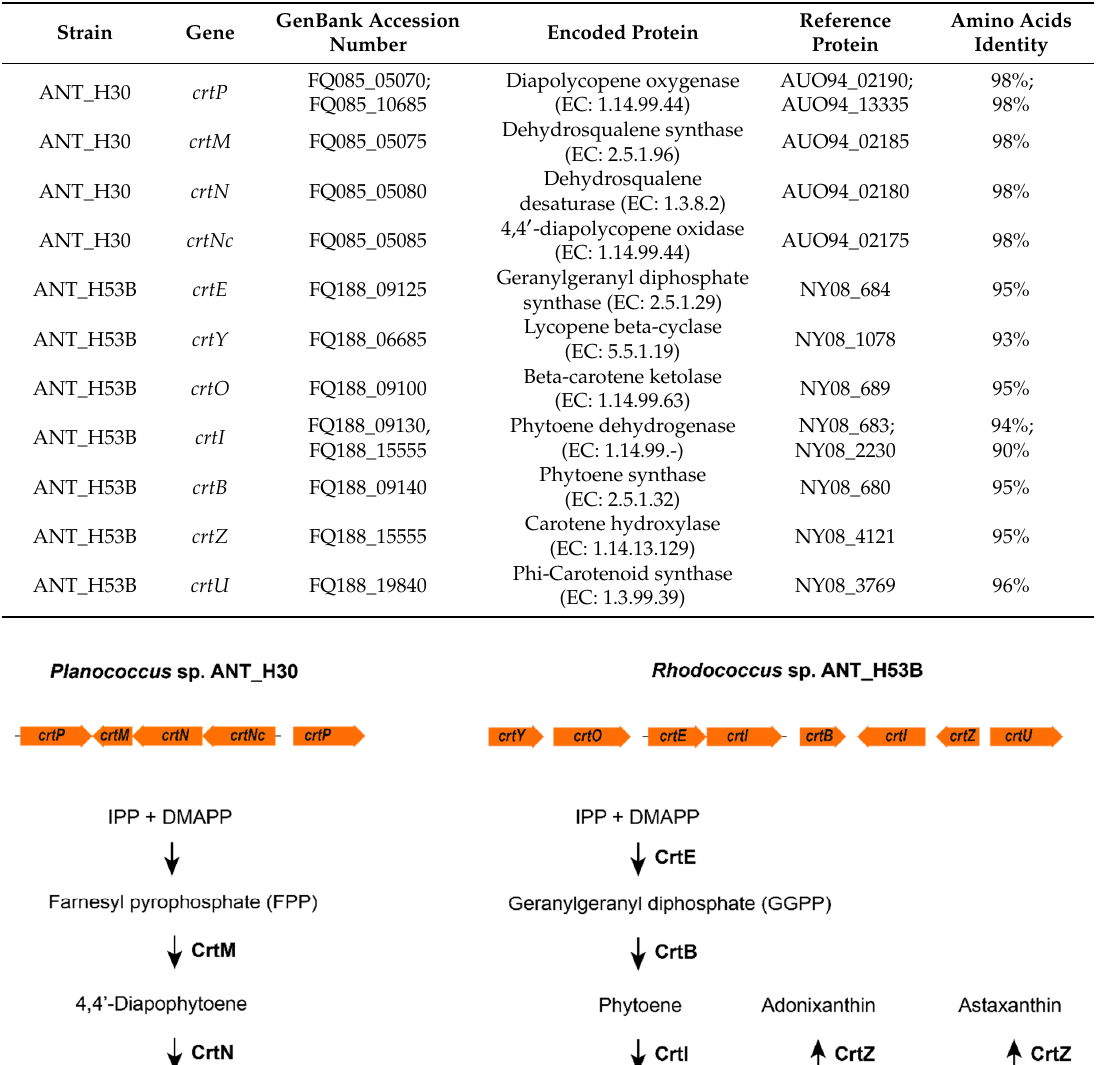
Table 2. Carotenoid biosynthesis enzymes encoded by ANT_H30 and ANT_H53B.